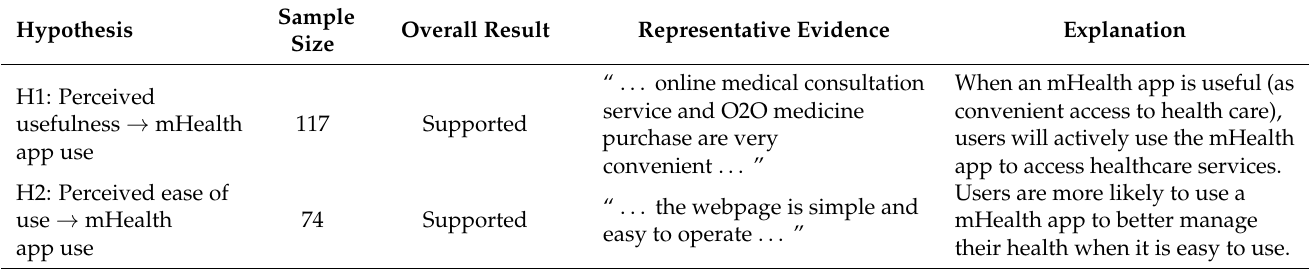
Table A2. Results of the Qualitative